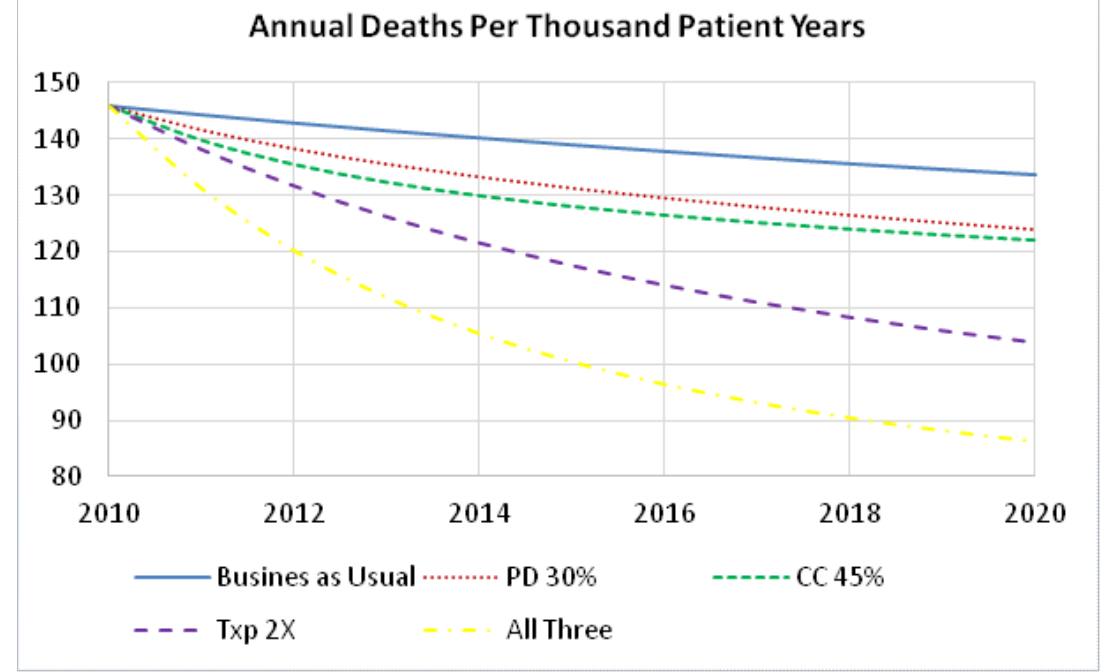
Figure 2. Source USRDS Annual Data Report 2013 and the ESRD Population